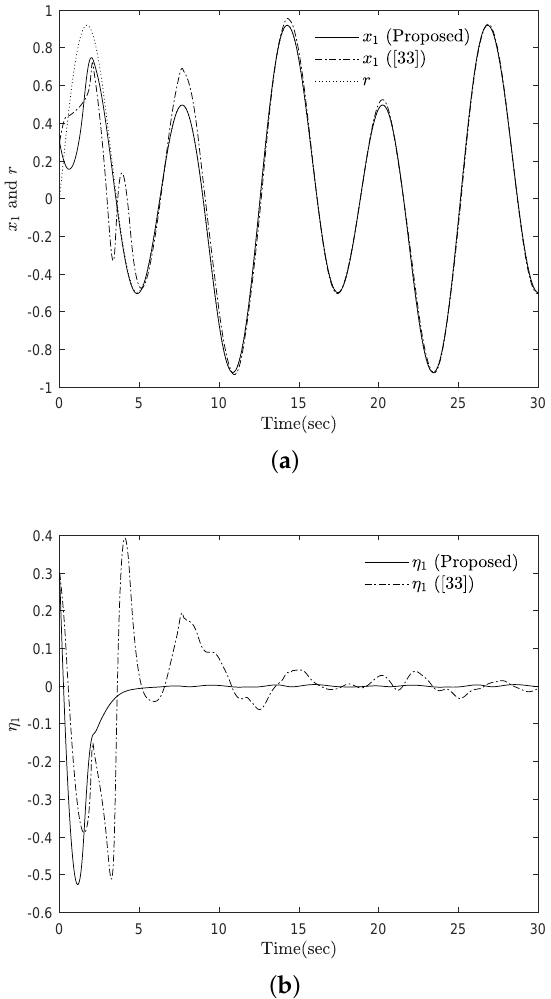
Figure 2. Comparison of the tracking result and error for Example 1: ( a ) x 1 and r ; ( b ) η 1